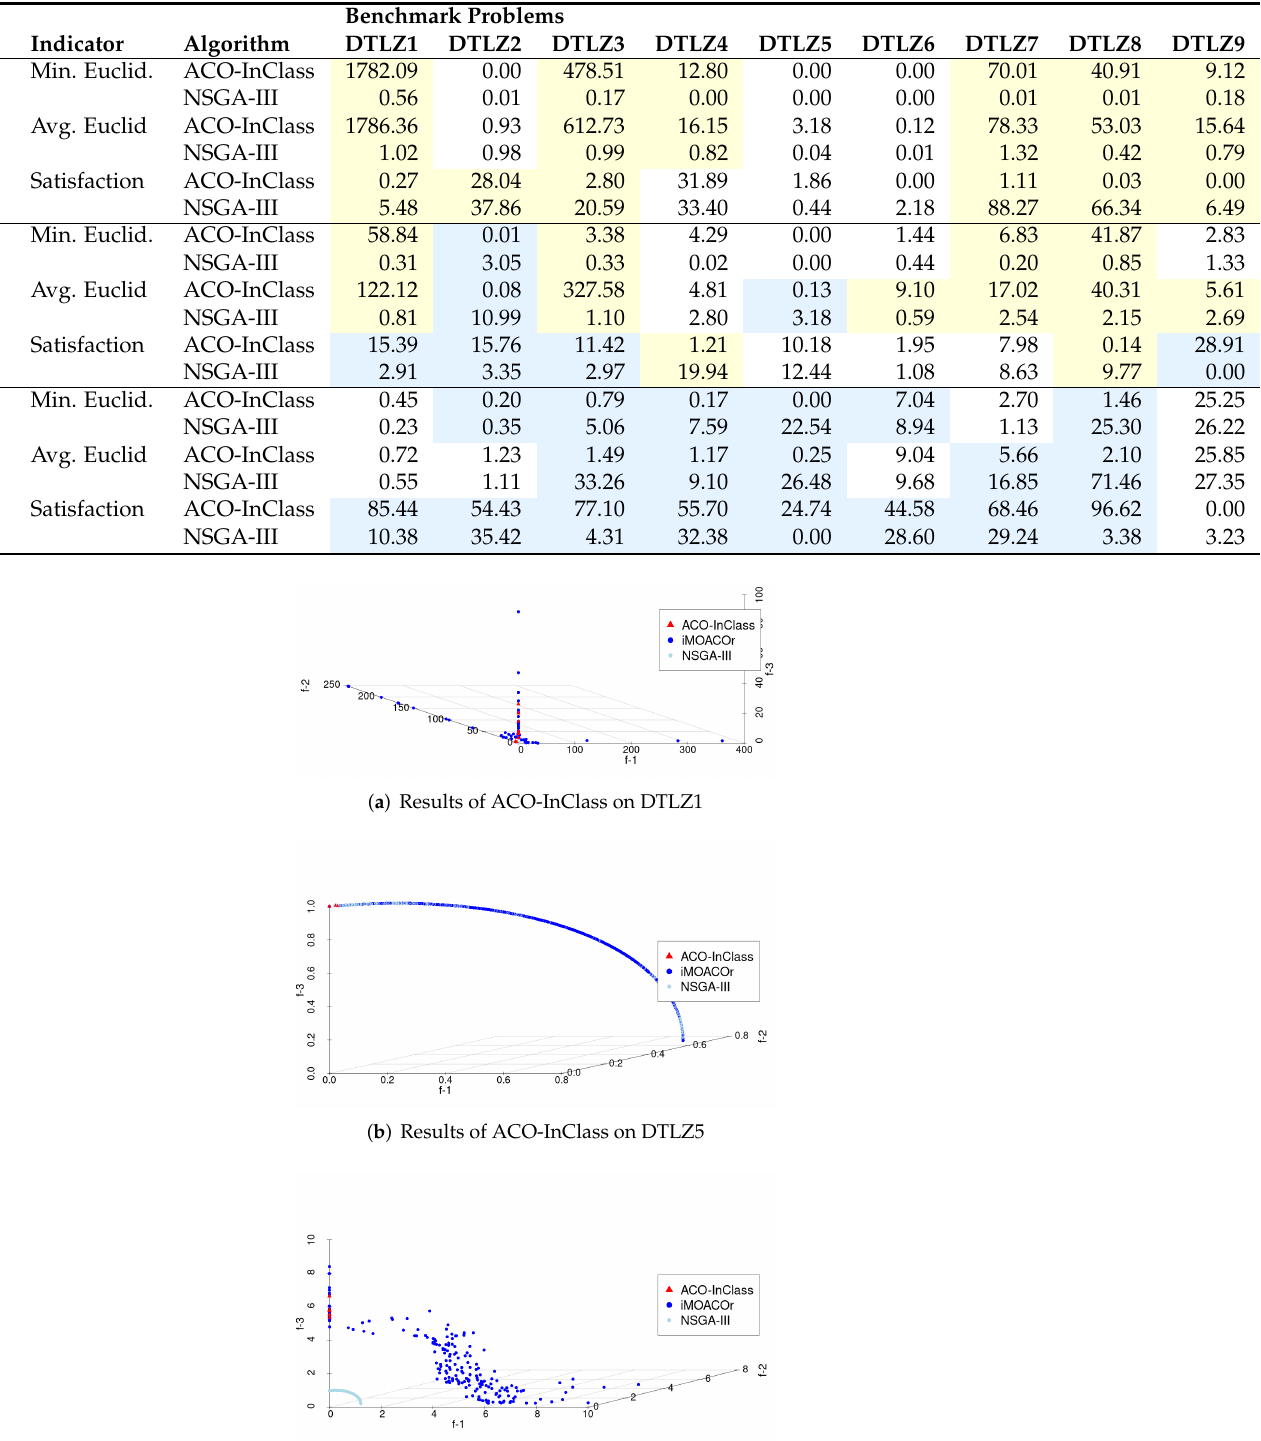
Table 4. Average results obtained by ACO-InClass and NSGA-III.